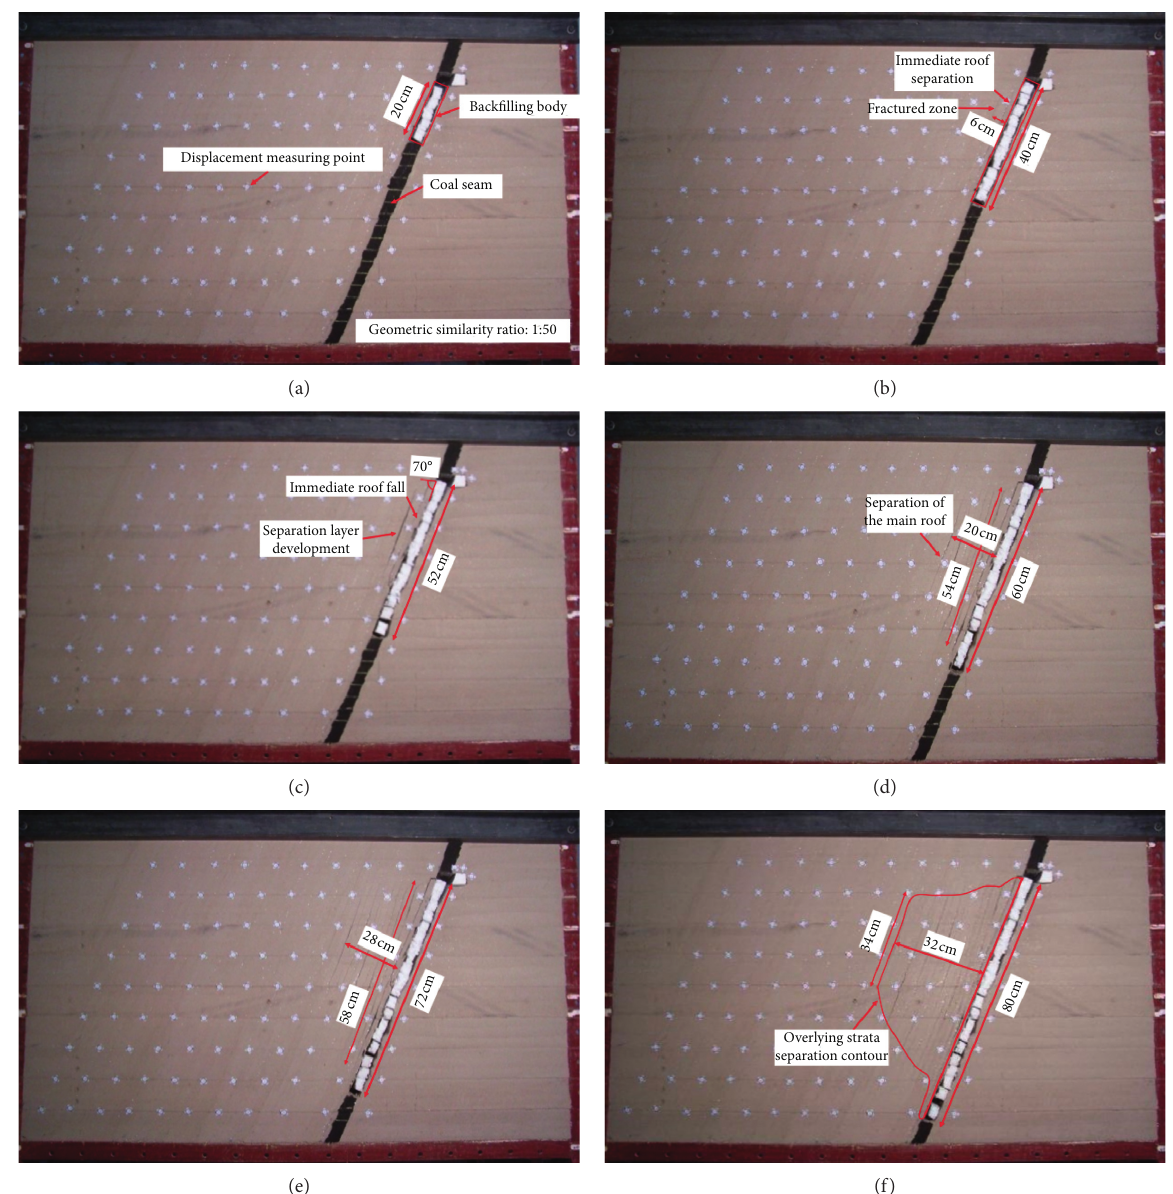
Figure 19: Surrounding rock movement and deformation of each mining stages. (a) 10 m. (b) 20m. (c) 26m. (d) 30m. (e) 36m. (f)